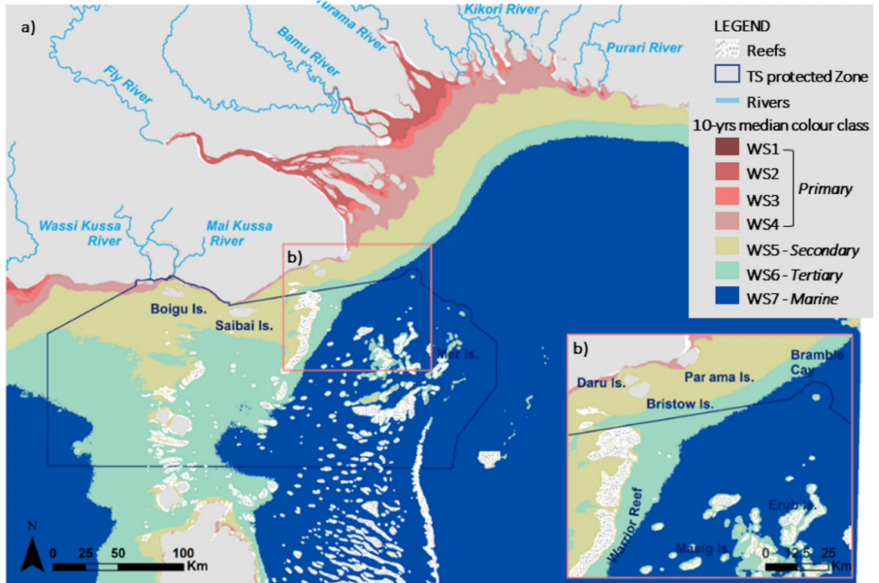
Figure 4. ( a ) Median decadal (2009–2018) colour class map illustrating long-term trends in turbidity levels in the study area, ( b ) Zoomed in map of Daru Island and the Warrior Reef ([22],